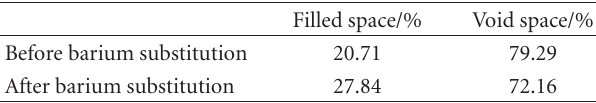
Table 8: Porosity osteoporosis bone for barium substitution. Filled